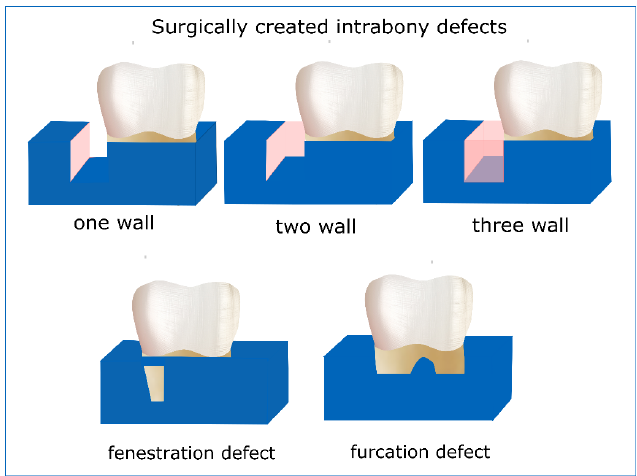
Figure 2. Most common employed periodontal defect models for periodontal tissue